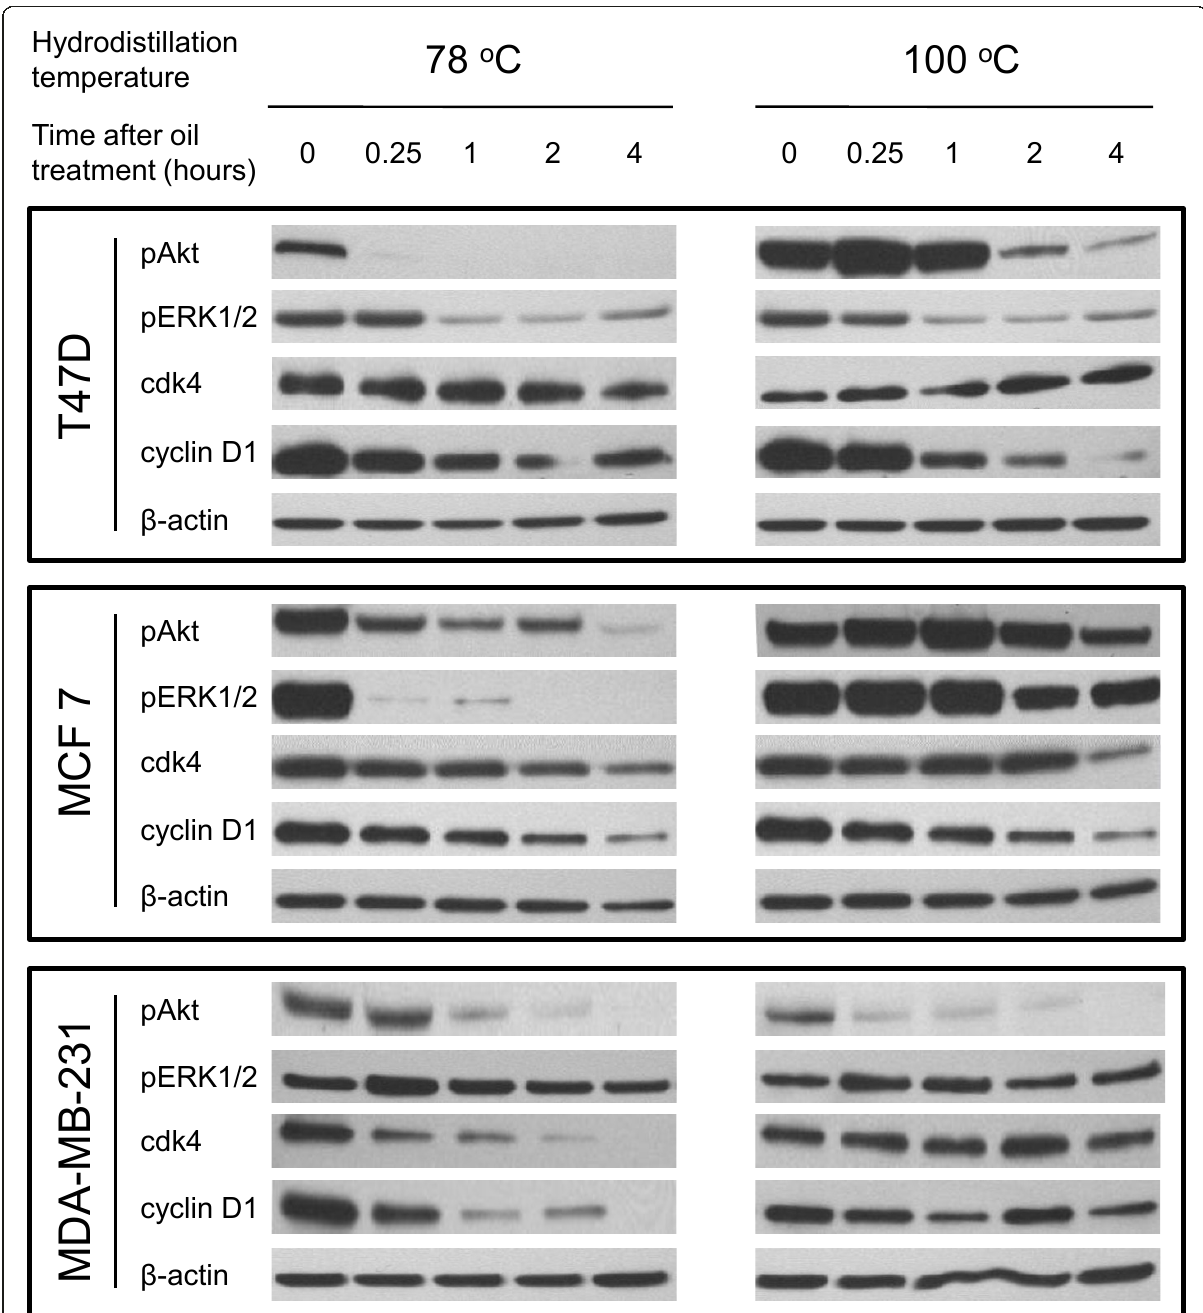
Figure 7 Boswellia sacra essential oil-regulated signaling molecules activation and cell cycle-related proteins expression in human breast cancer cells . Breast cancer cells were seeded at the concentration of 5 × 10 5 cells/60 mm tissue culture plate. After adherence,